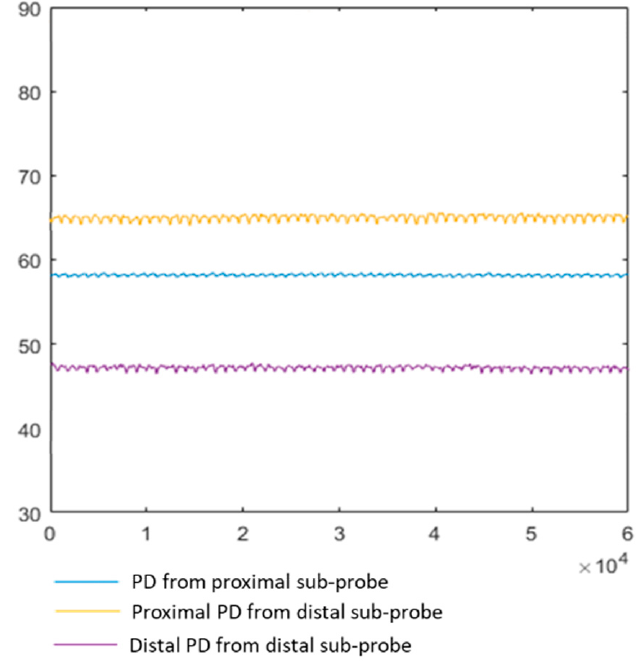
Figure 9. Light intensity DC from all three photodetectors at 810 nm. The ZenTBI system fulfilled the design requirements for acquiring PPG and NIRS signals, which were methodically evaluated in an in vitro setup. This study showed the morphology of the pulsations and calculated some quality indices to evaluate the signals. Even though the signals’ quality depends on the subject (in vitro/in vivo), the PPG signals acquired from the phantom using artificial blood successfully led to the extraction of quality measurements. Still, there is always room for improvement in the acquisition system design. Other authors have reported techniques to reduce the impact of ambient light, signal saturation, and movement artefacts in pulsatile signals [29,30], which could be added to the current ZenTBI system to reduce common noise sources. For instance, an ambient light cancellation circuit would avoid signal saturation due to high levels of ambient light or small gaps between the sensor and the measuring surface. Moreover, the separation of the AC and DC components using analogue filters could allow higher amplification of the pulsatile signals to improve the quality of these signals, as well as the implementation of an offset cancelling circuit to reduce the movement artefacts in the pulsatile